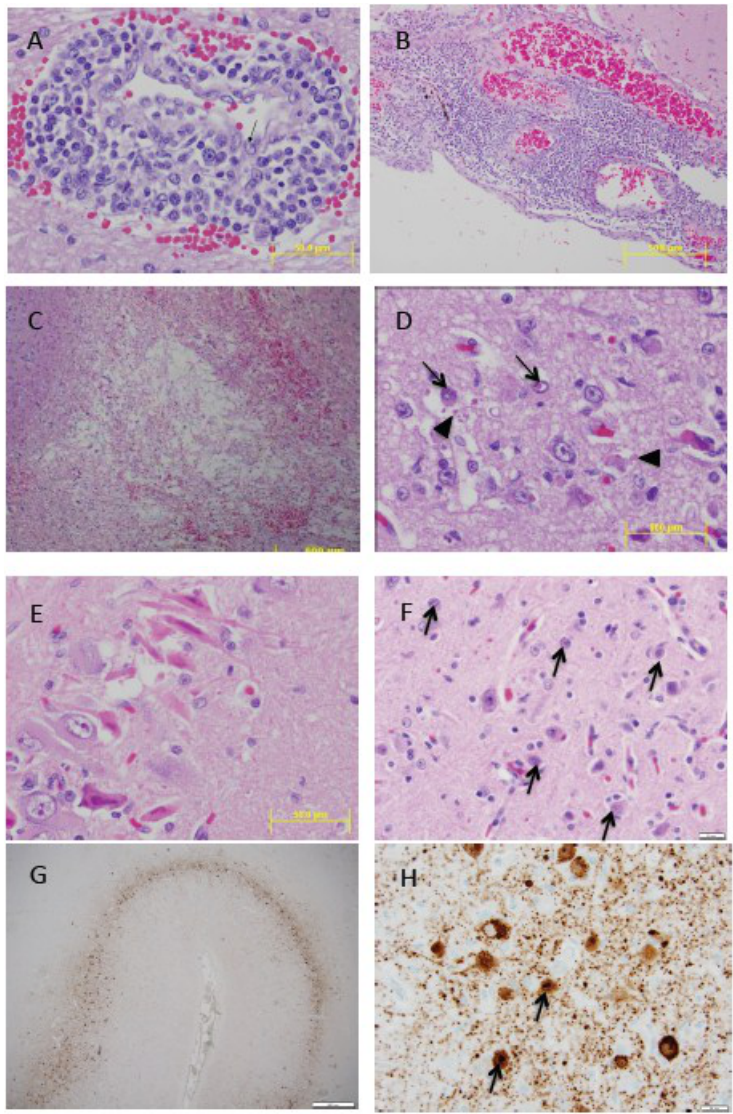
Figure 2. ( A ) Grey seal ( Halichoerus grypus ) cerebrum showing expanded Virchow Robin space containing lymphocytes. Activated endothelial cell (arrow). H&E stain ( B ) Grey seal cerebrum with marked non-suppurative meningoencephalitis. H&E stain ( C ) Grey